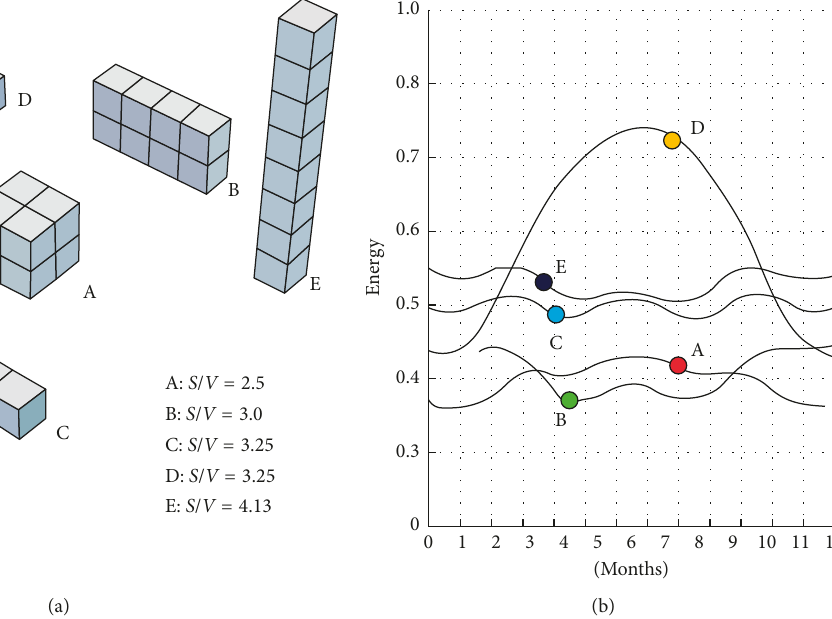
Figure 3: Surface-to-floor area